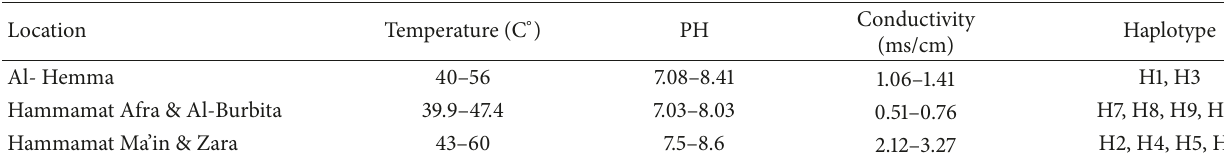
Table 1: Physicochemical properties of the hot springs.